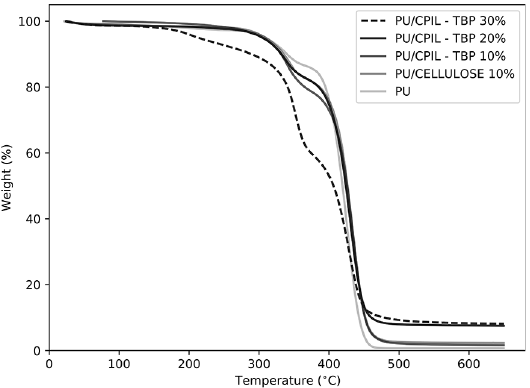
Figure 4. TGA thermograms of PU and PU composites. DSC curves (Fig. 5) obtained for PU and PU composites showed an endothermic peak (T =19°C, PU/CELLULOSE 10% = 12°C, PU/CPIL-TBP 10% = 13°C, PU/CPIL-TBP 20%= 21°C and PU/CPIL- TBP 30%= 21°C) associated to the melting of crystalline microphase due to molecular weight (Mn= 2000) of soft segments (PTMG) promoting crystallization 41,42